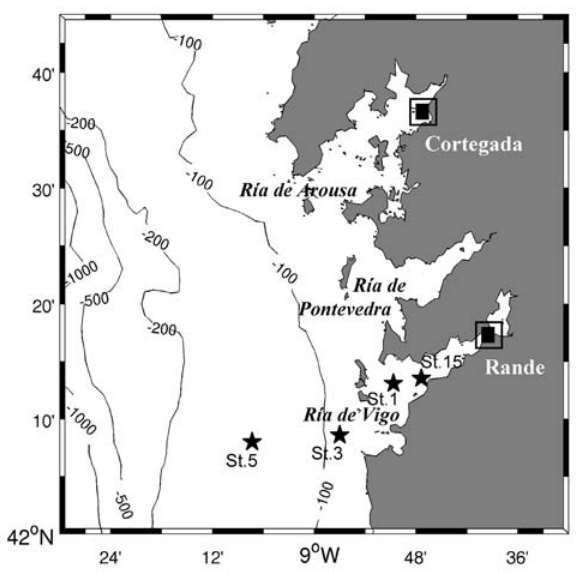
Fig . 8. – Location of the monthly CTD sampling in the Ría de Vigo and adjacent shelf (St.15, St.1, St.3 and St.5) and the oceanographic platforms of Cortegada and Rande. The 100, 200, 5000 and 1000 m isobaths are plotted for